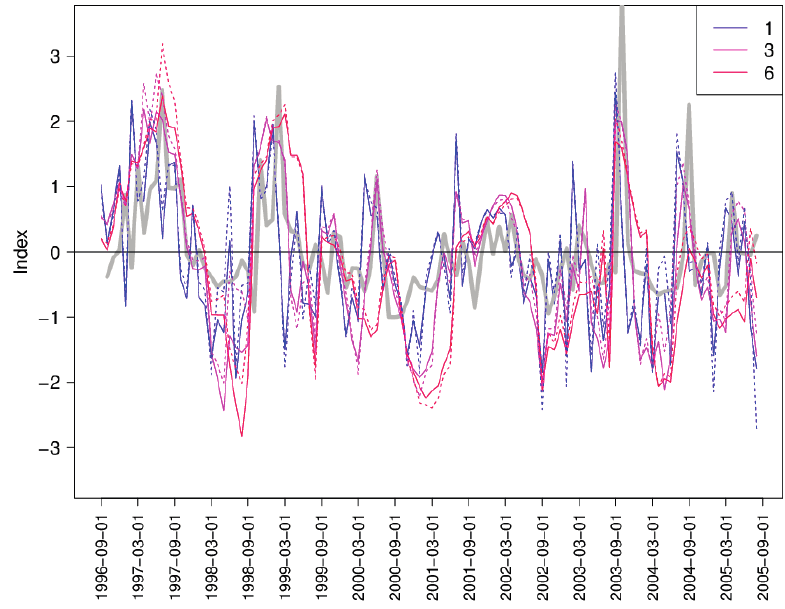
Figure 9. The Standard Precipitation Evaporation (SPEI) and Standard Precipitation (SPI) Indices for the one, three, and six-month time scale and the standardized runoff for the SR (grey) over